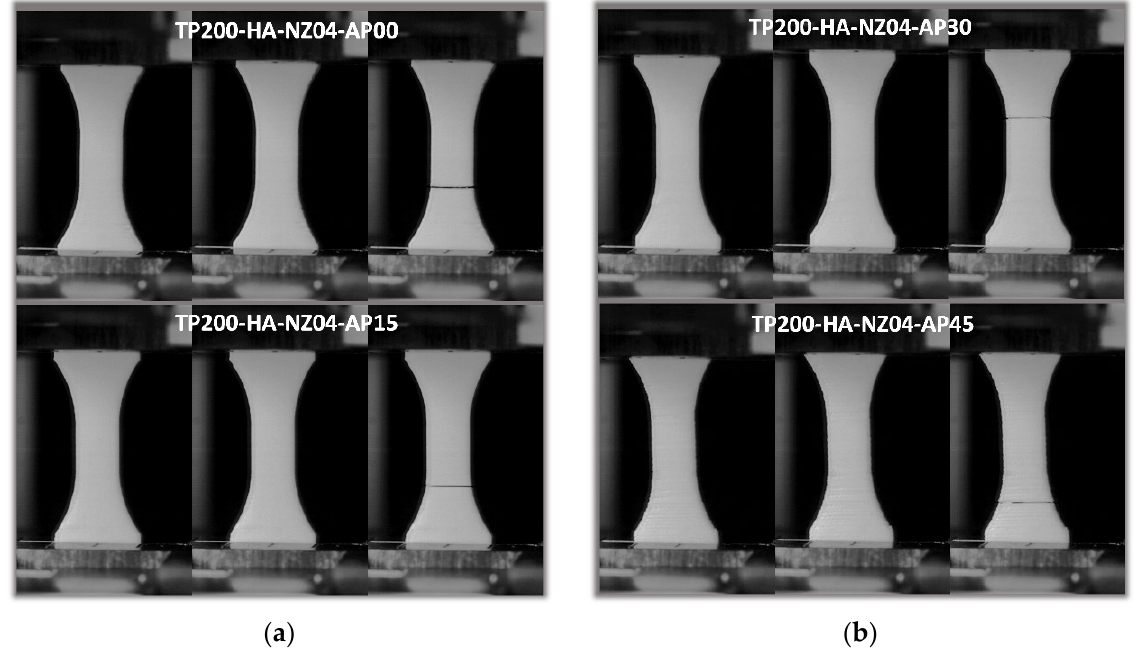
Figure 9. Effect of vertical orientation (HA) on the tensile behaviour of PLC for different in-plane printing angles: ( a , b ) close-up view of a filament and 3D-printed PLC sample.